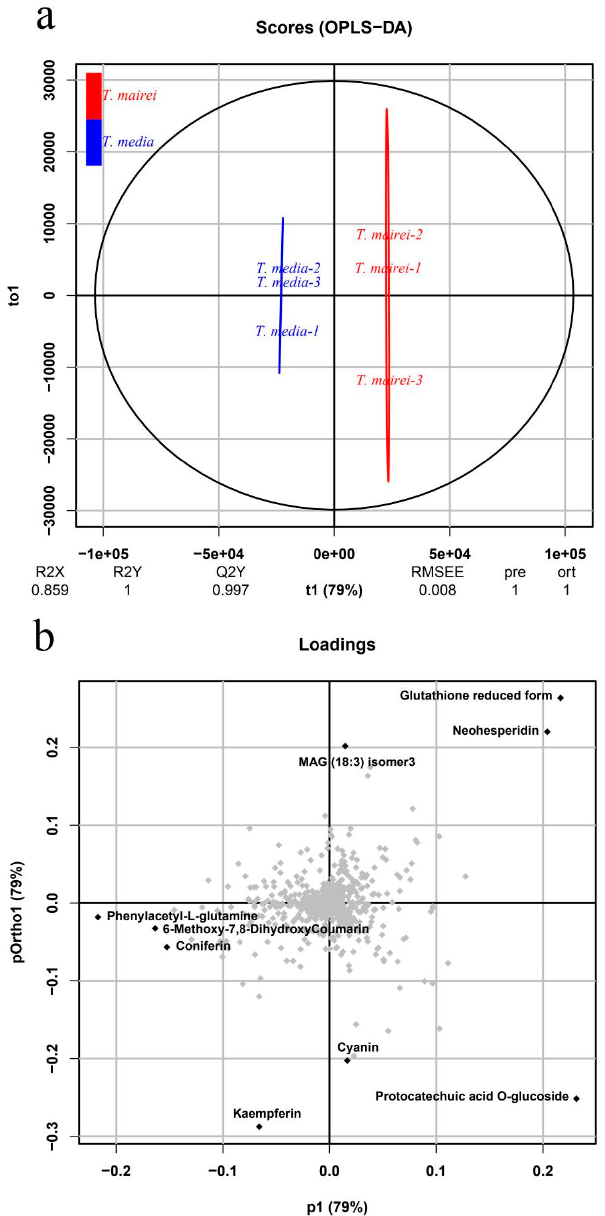
Figure 3. Differential metabolite analysis conducted by orthogonal projection to latent structures- discriminant analysis (OPLS-DA). ( a ) OPLS-DA score plot comparing T. mairei and T. media . ( b ) OPLS-DA loading plot comparing T. mairei and T. media .